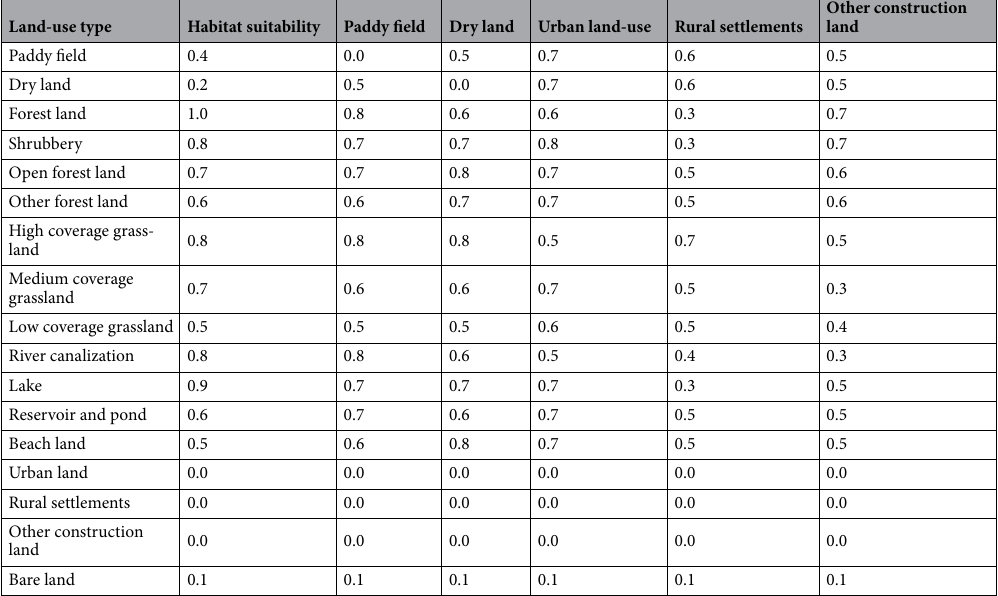
Table 3. Habitat suitability and sensitivity of land-use types to each threat factor.